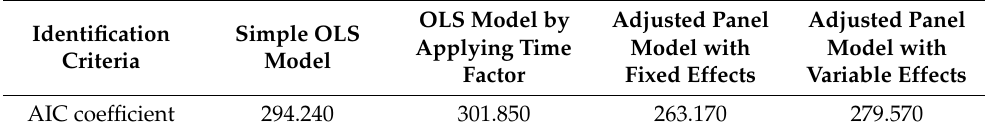
Table 2. The results of AIC statistics for the research